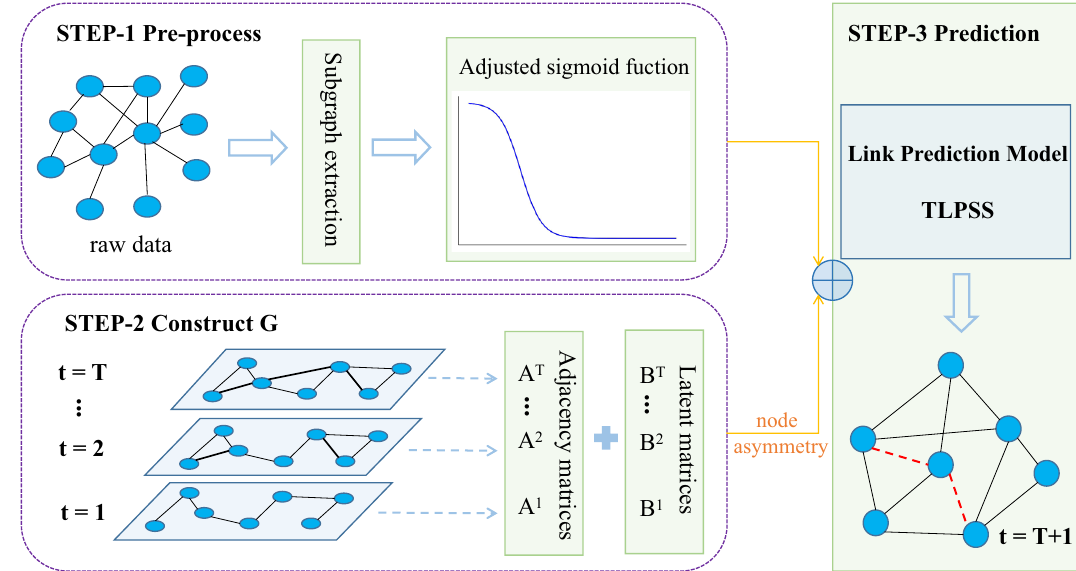
Figure 5. Diagram of the proposed model TLPSS. This model contains pre-process, construct graph and prediction steps. In first step, the data is processed and decayed by ASF . Then, according to the network snapshots, we obtain the adjacency matrix sequence and latent matrix sequence. Finally, coupling the temporal and structural information, the temporal link prediction method TLPSS is